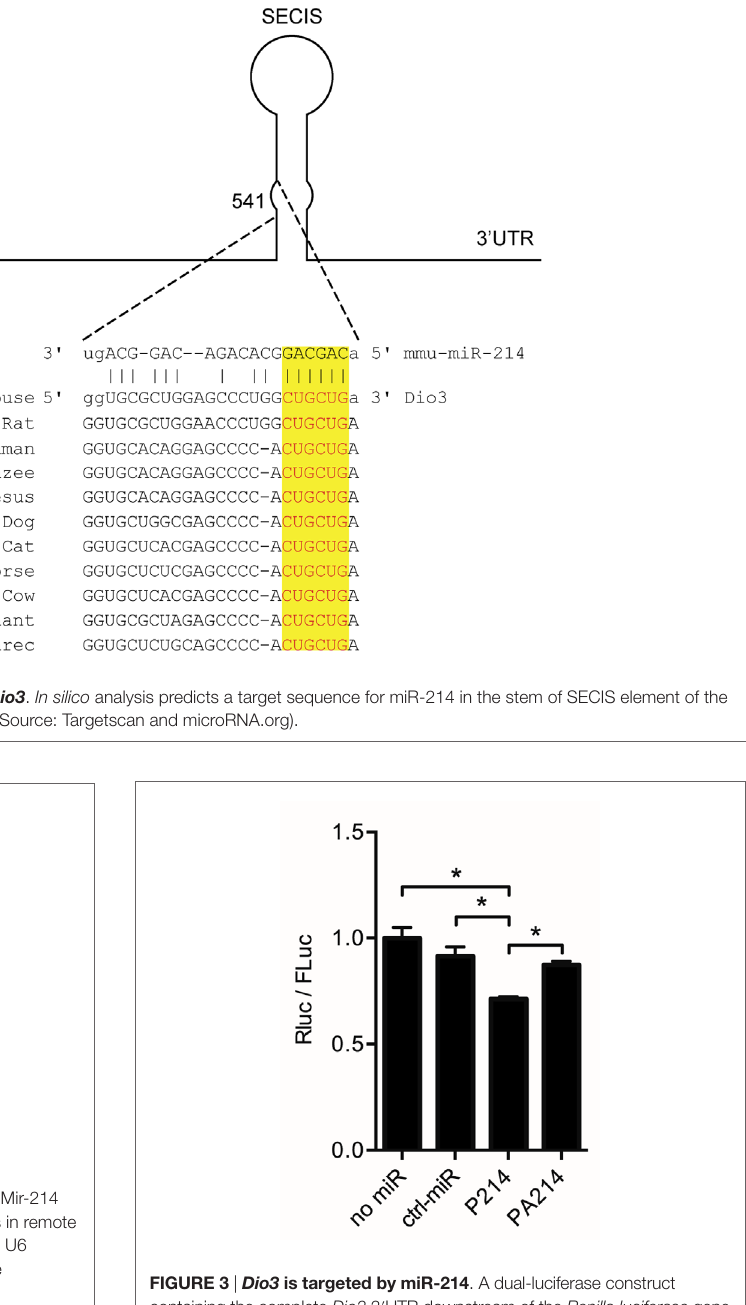
FigUre 3 | Dio3 is targeted by mir-214 . A dual-luciferase construct containing the complete Dio3 3 ′ UTR downstream of the Renilla luciferase gene was used to analyze the interaction between miR-214 and the 3 ′ UTR of Dio3 . Renilla luciferase activity (RLuc) is expressed relative to firefly luciferase activity (FLuc), correcting for differences in transfection efficiency. Four independent transfections were performed in duplicate. No-miR: control without co- transfection; ctrl-miR: + negative control/scrambled miR-1; P214: + Pre- miR-214; PA214: + Pre-miR-214 and Anti-miR-214. Values are means ± SEM, n = 4, normalized to the RLuc/Fluc ratio in the no-miR group, * p <